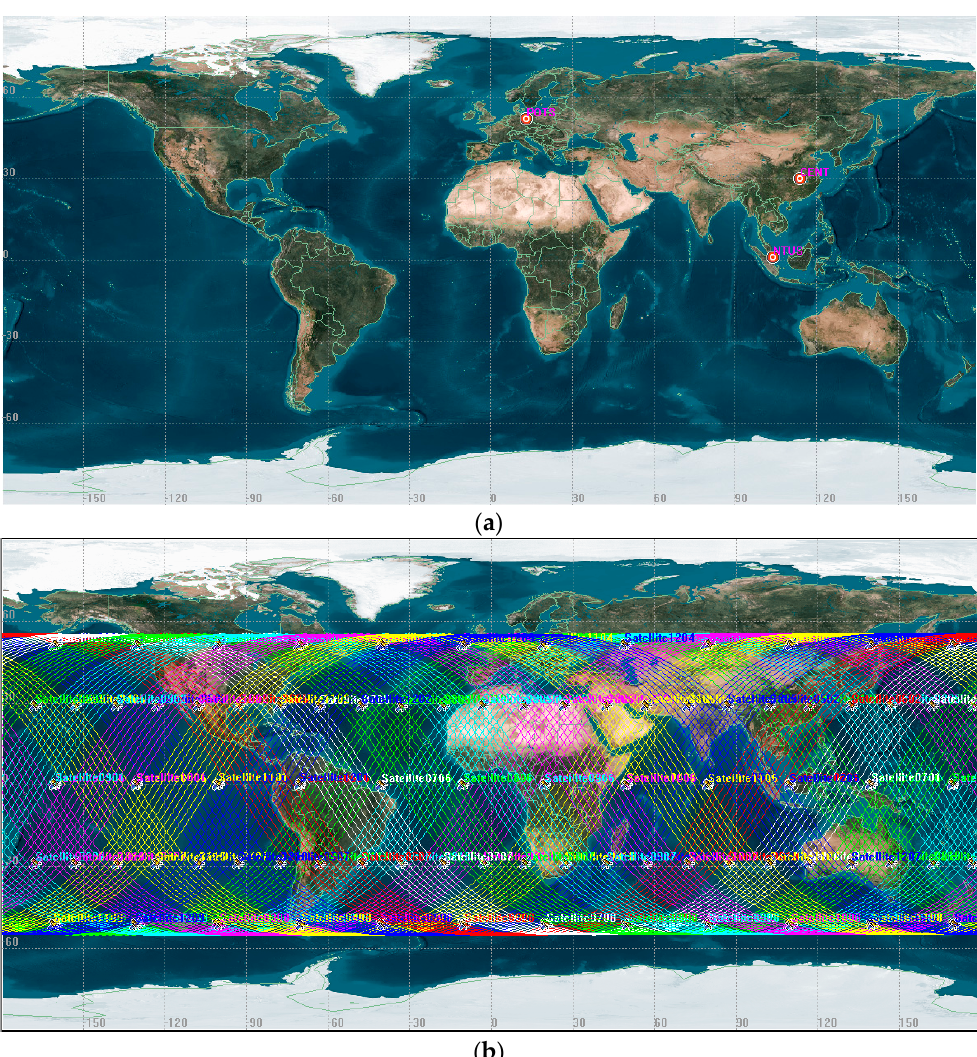
Figure 1. The satellite distribution of the BeiDou-3 and LEO constellation.